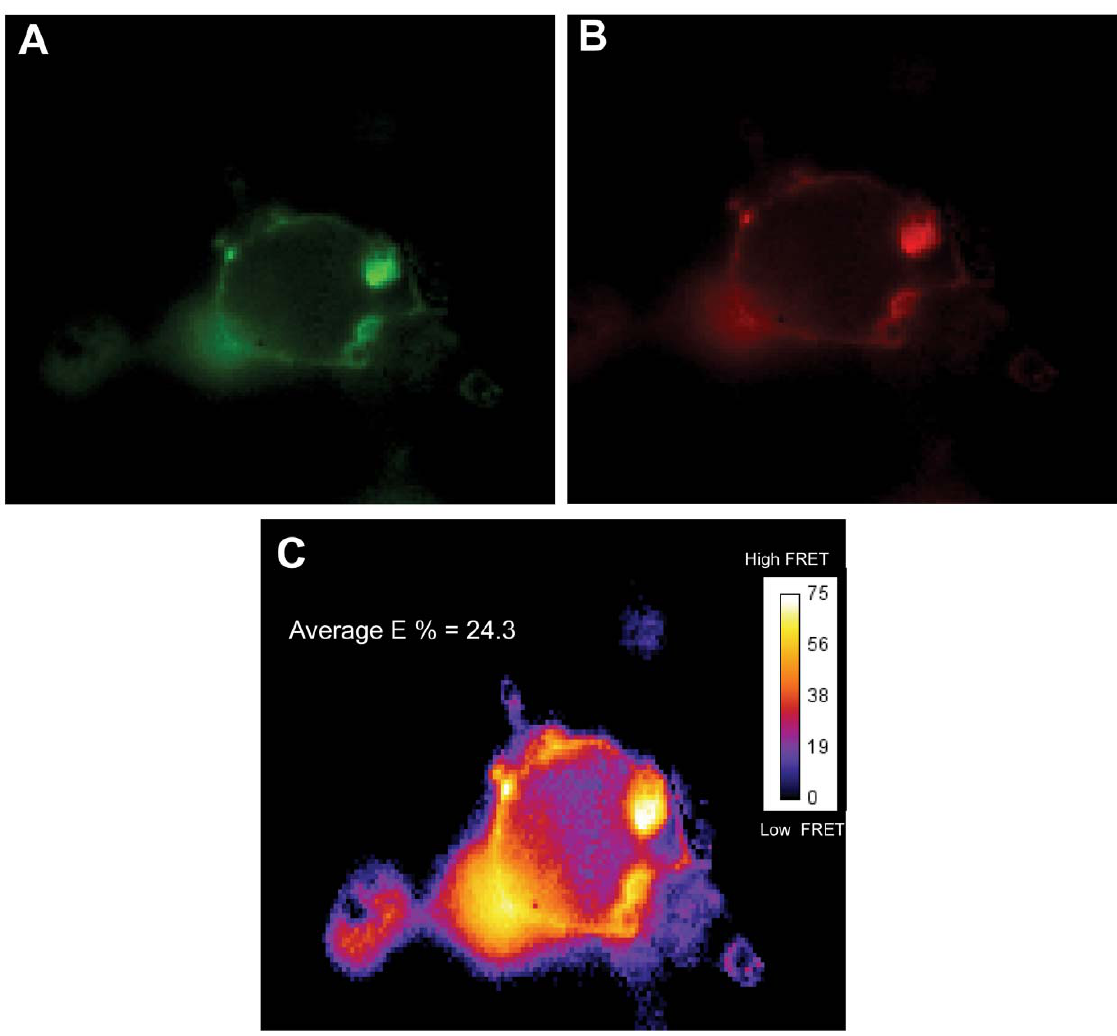
Figure 5. FRET on HA and Myc tagged ectodomain constructs in HEK 293 cells. HA-GPI-TSHR-ecd and myc-GPI-TSHR-ecd were co- transfected into HEK 293 cells and stained with anti-HA FITC and anti-Myc Cy3 labeled antibody and imaged for energy transfer between FITC (donor) and Cy3 (acceptor) fluorophores. As described in Materials and Methods single transfected cells labeled with anti-HA-FITC and anti-Myc-Cy3 alone were the endogenous control for lack of FRET and for correction of donor and acceptor spectral bleed through. Panel A shows the staining of GPI- TSHR-ecd by anti HA FITC. Panel B shows the same cell stained with anti Myc Cy3. Panel C is the pseudo colored FRET energy level image obtained from the analysis of the double transfected cells by using the pFRET software. The calibration bar indicates the FRET energy t level in the cell. Energy transfer was in the range of 8–10% on the surface of the cells compared to controls (TSHRGFP + TSHRmyc labeled with Cy3) which showed energy transfer of